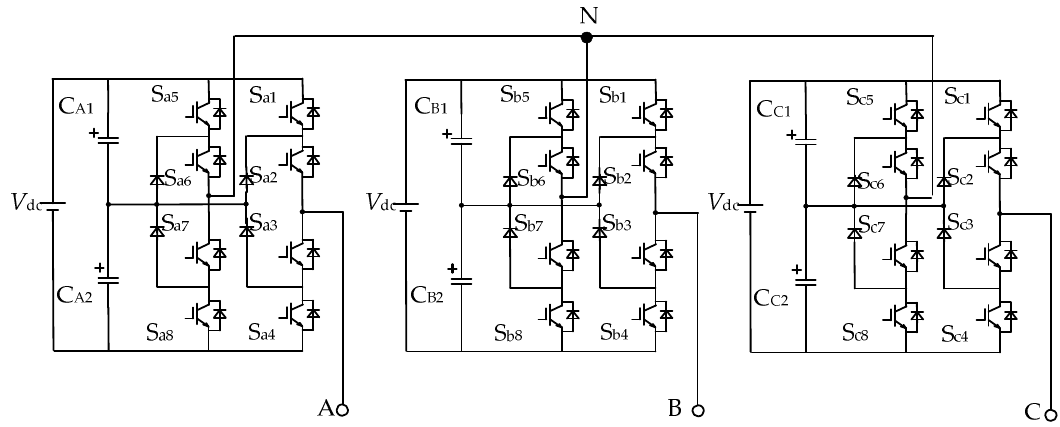
Figure 1. Three-phase NPC/H bridge five-level inverter topology.